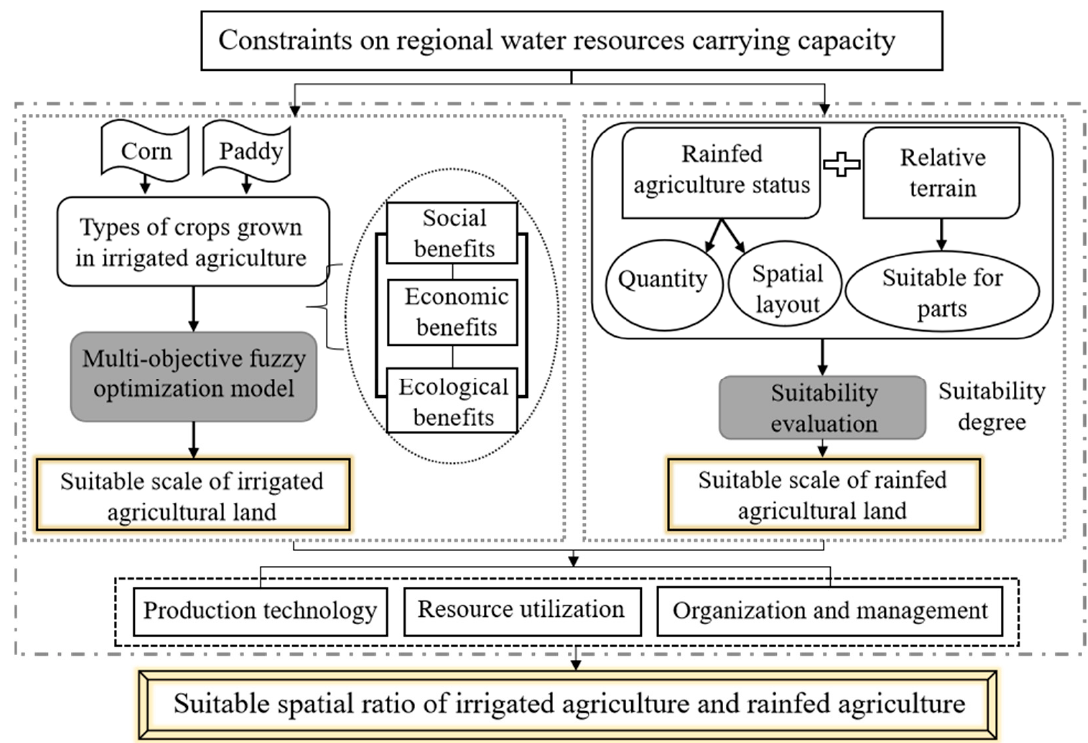
Figure 2. The research framework for the distribution of irrigated and rainfed agricultural land in the semi-arid sandy region.